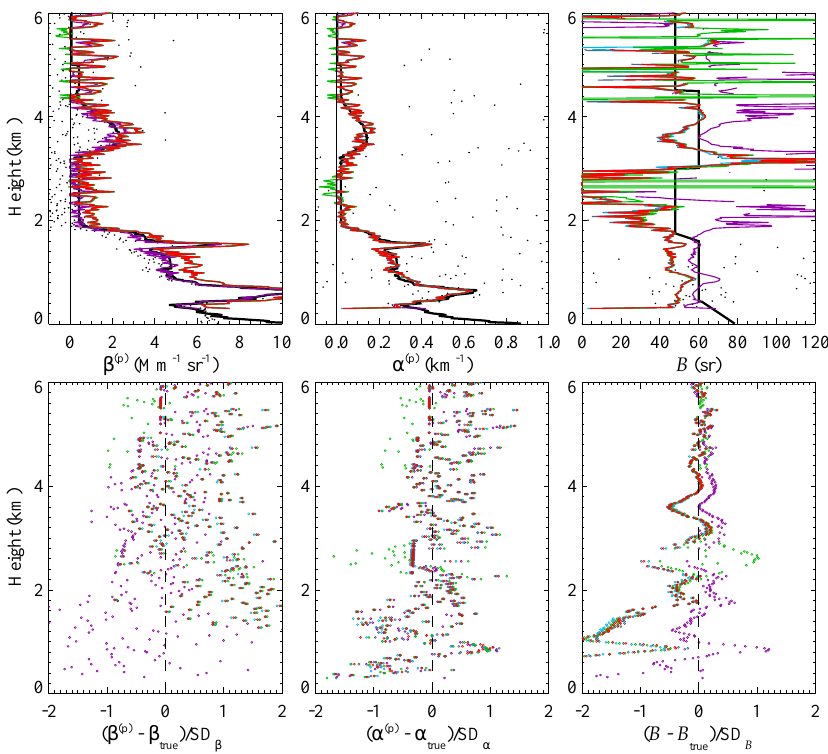
Fig. 12. Performance of the retrieval (extinction mode) with data simulated by EARLINET. (Top) The simulated backscatter, extinction, and lidar ratio (black) compared to that from the Ansmann method (points) and retrieval (red). Also shown are the retrievals where the a priori is increased or decreased by 20% (grey and blue), where the retrieval has been allowed to take negative values (green), and where the magnitude of the calibration function has been manually selected to improve the comparison. (Bottom) The difference between those retrievals and the simulated profile, normalised by the estimated standard deviation (Ansmann not shown).